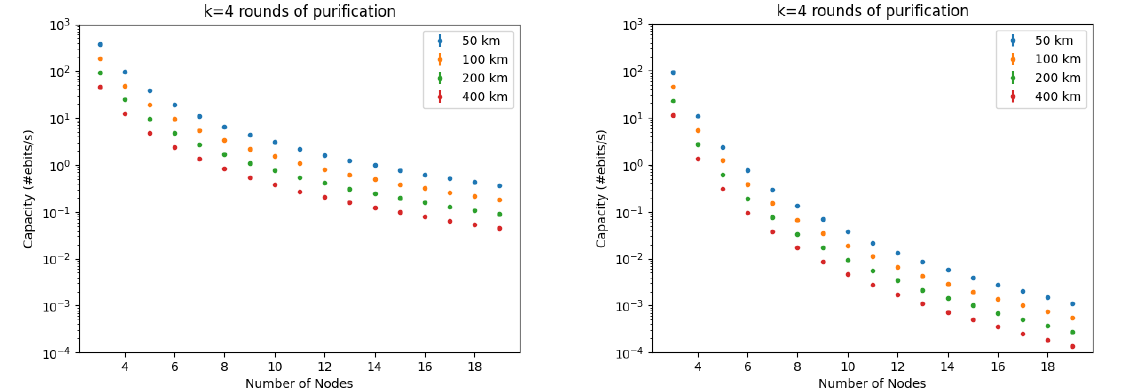
Figure 2. Capacity upper bounds for QR chains with entanglement swapping and k rounds of purification, using Deutsch’s